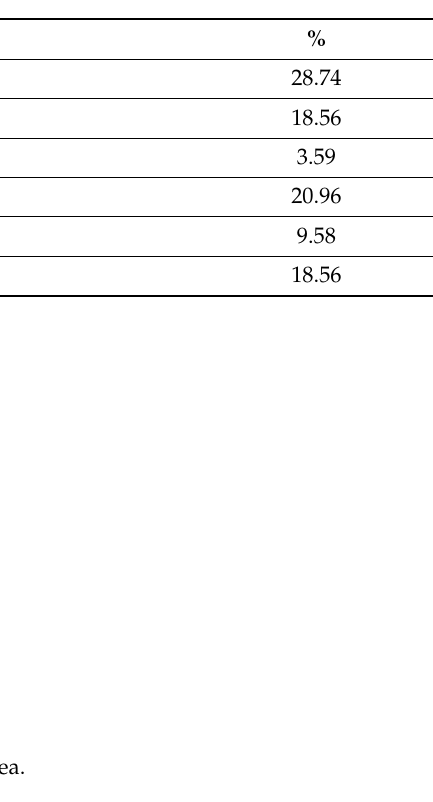
Table 3. Route of transmission of the study group .